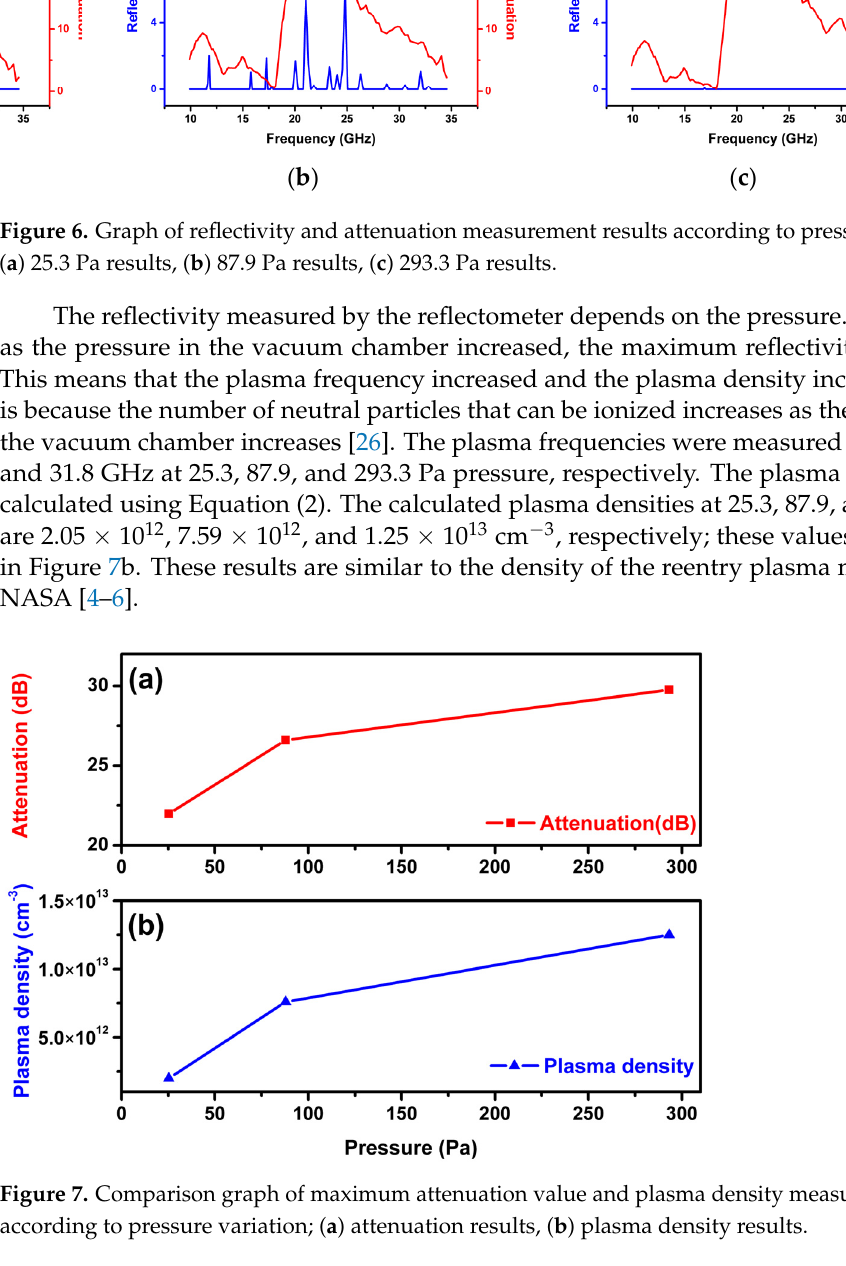
according to pressure variation; ( a ) attenuation results, ( b ) plasma density results.